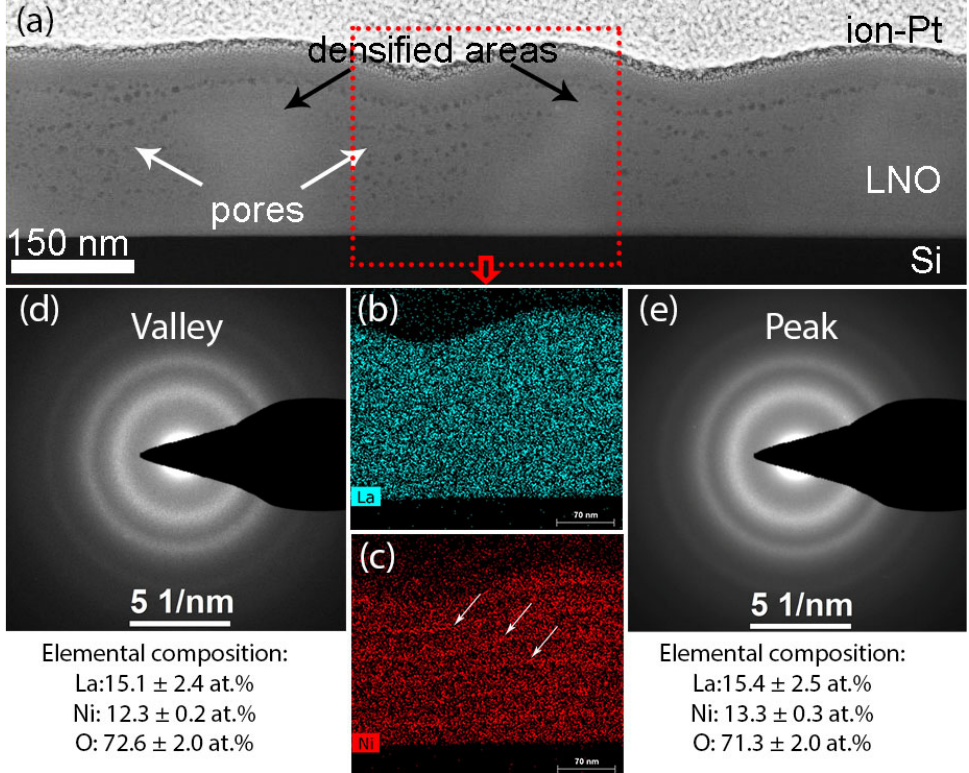
Figure 4. Microstructure of the multilayer LNO film, obtained by layer ‐ by ‐ layer deposition with drying at 300 °C of each layer: HAADF ‐ STEM image ( a ), EDX maps of La ( b ) and Ni ( c ), SAED patterns from the valley ( d ) and from the peak ( e ).